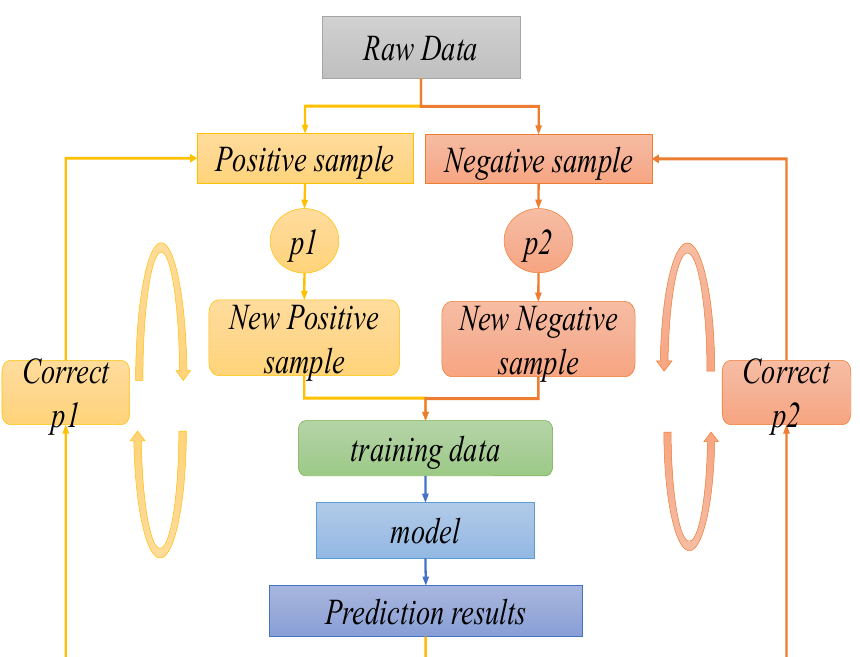
Figure 5. The prediction model diagram of NSCLC based on dynamic sampling technique for small samples.